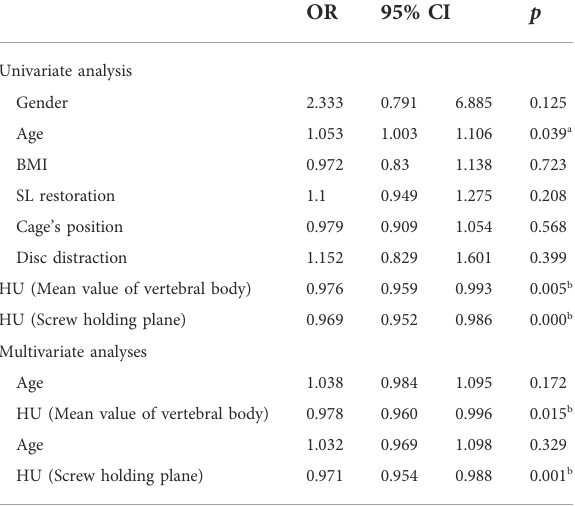
TABLE 4 Logistic regression analysis of the cranial screw loosening.